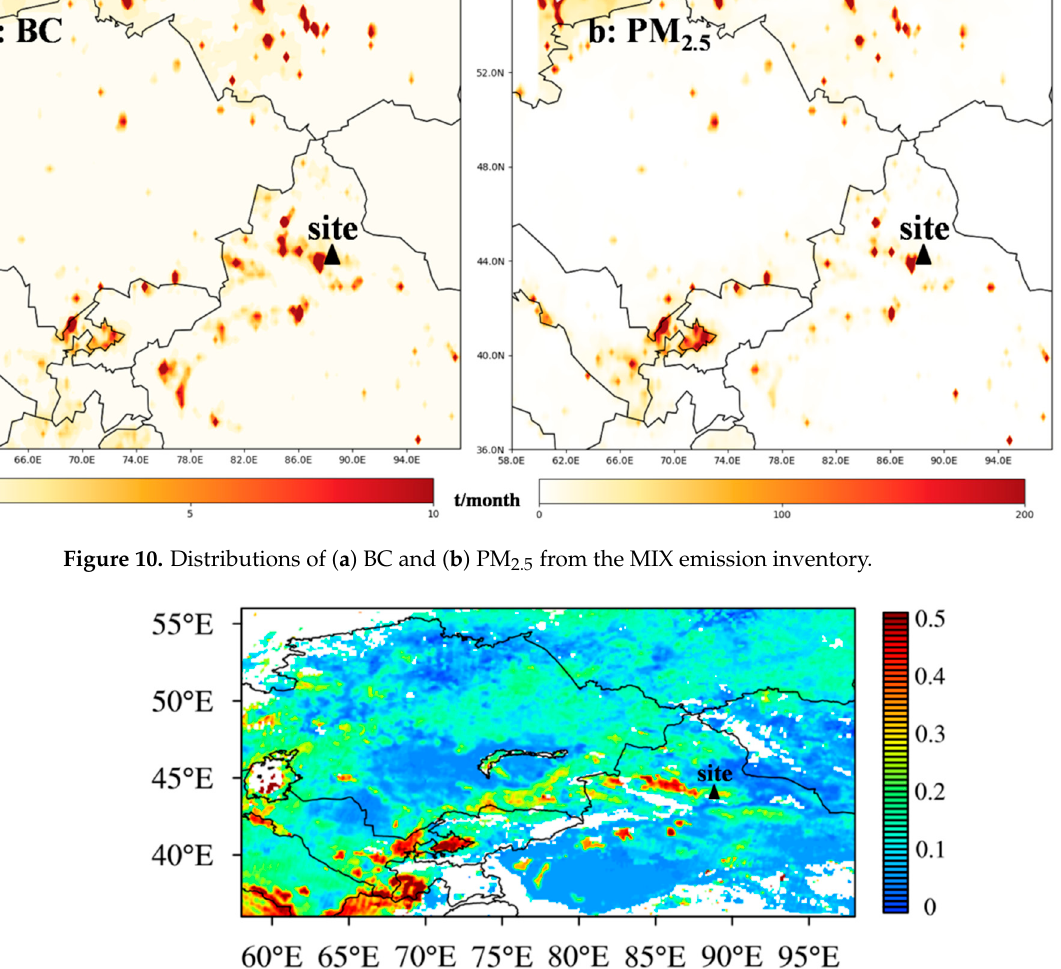
Figure 11. AOD distributions during the observation period.